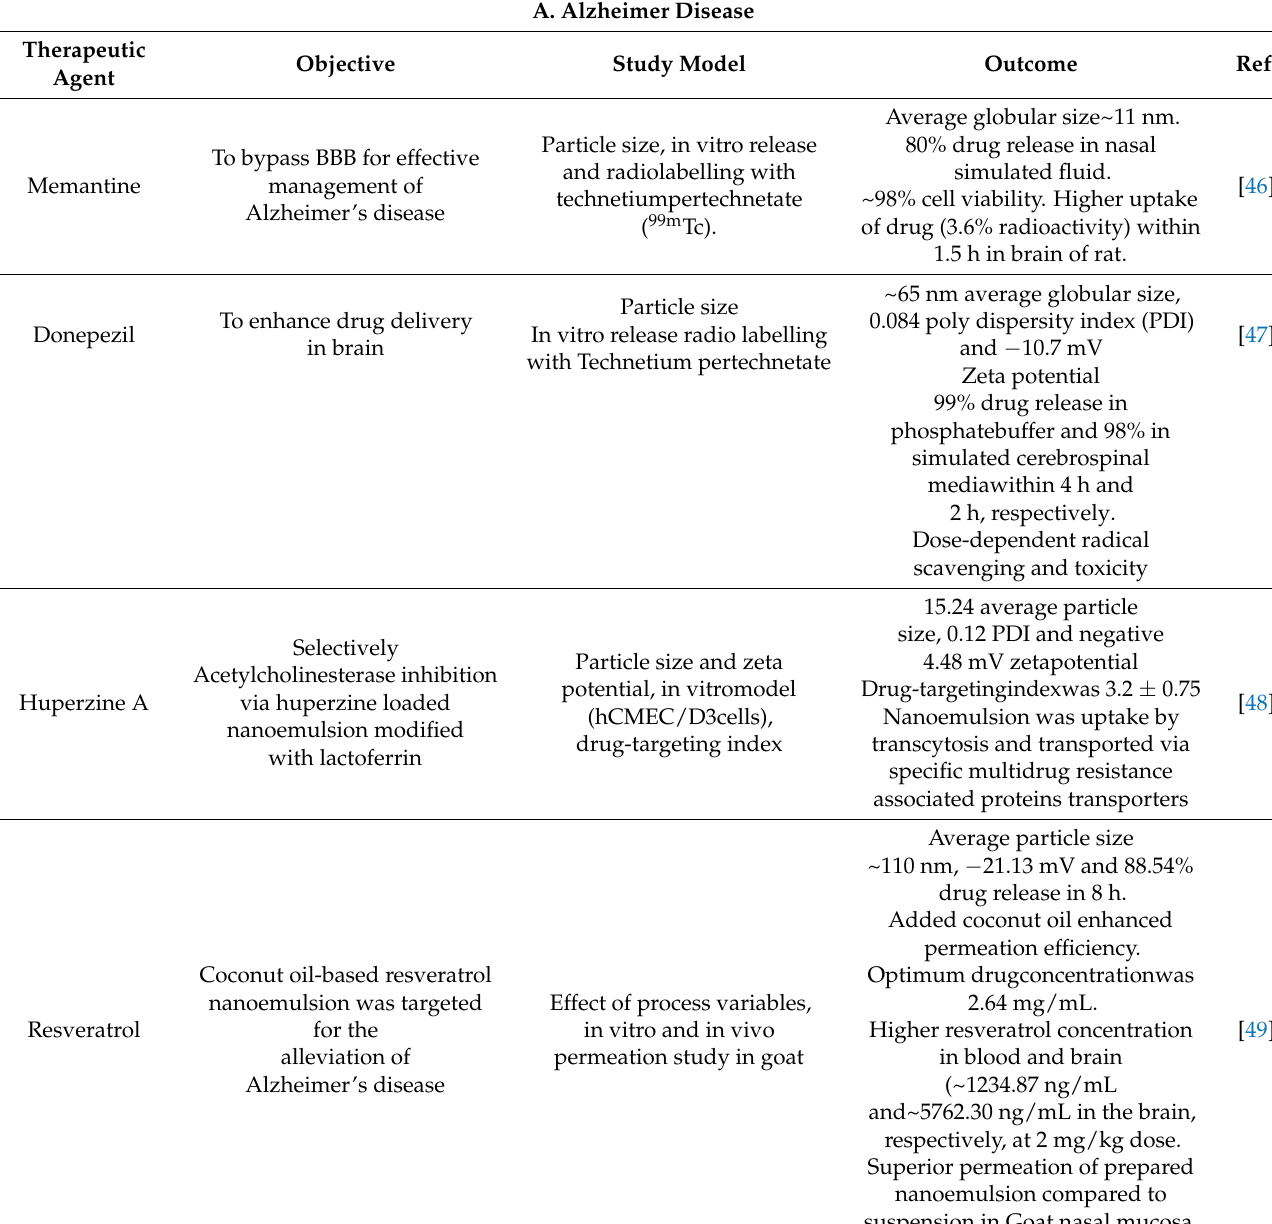
Table 2. Recently developed nanoemulsions for the management of diverse